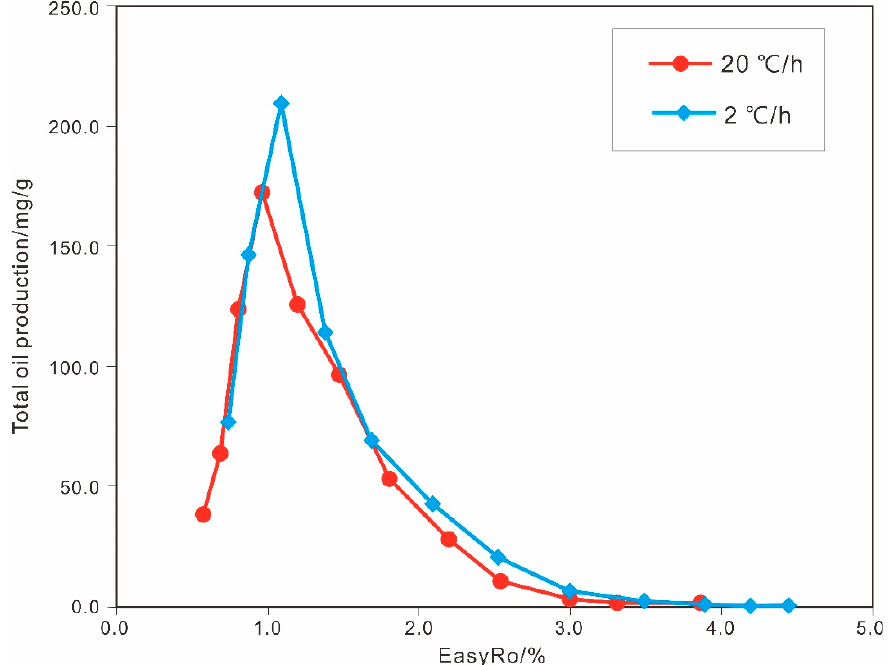
Figure 10. Simulation results of the oil production rate under different heating rates of the P 2 l source rocks in the Jimsar Depression.